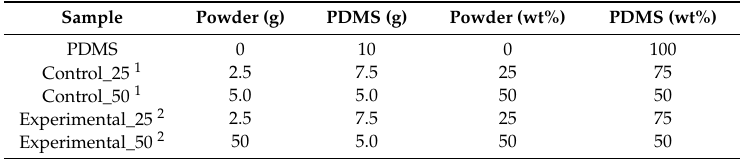
Table 2. Experimental conditions for aronia bioelastomer